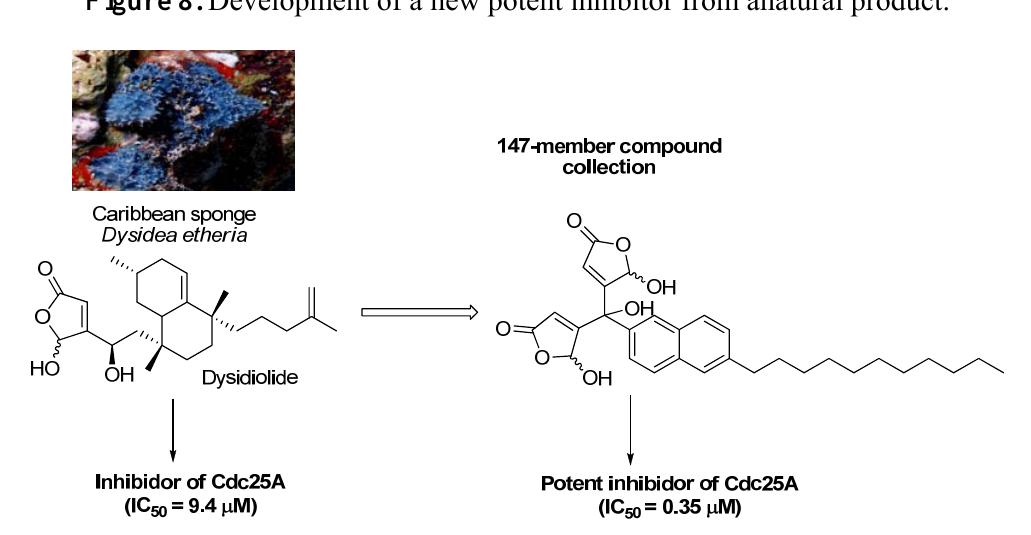
Figure 8. Development of a new potent inhibitor from anatural